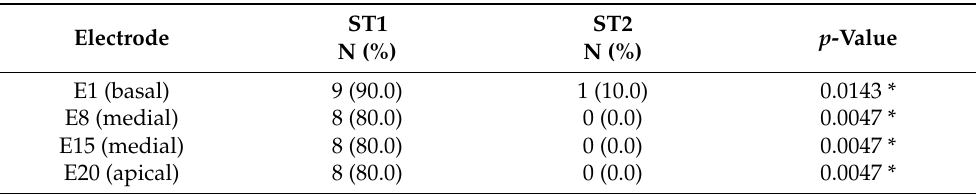
Table 3. Proportion of intraoperative EMG responses recorded in each tested electrode using the stimulation patterns ST1 and ST2.